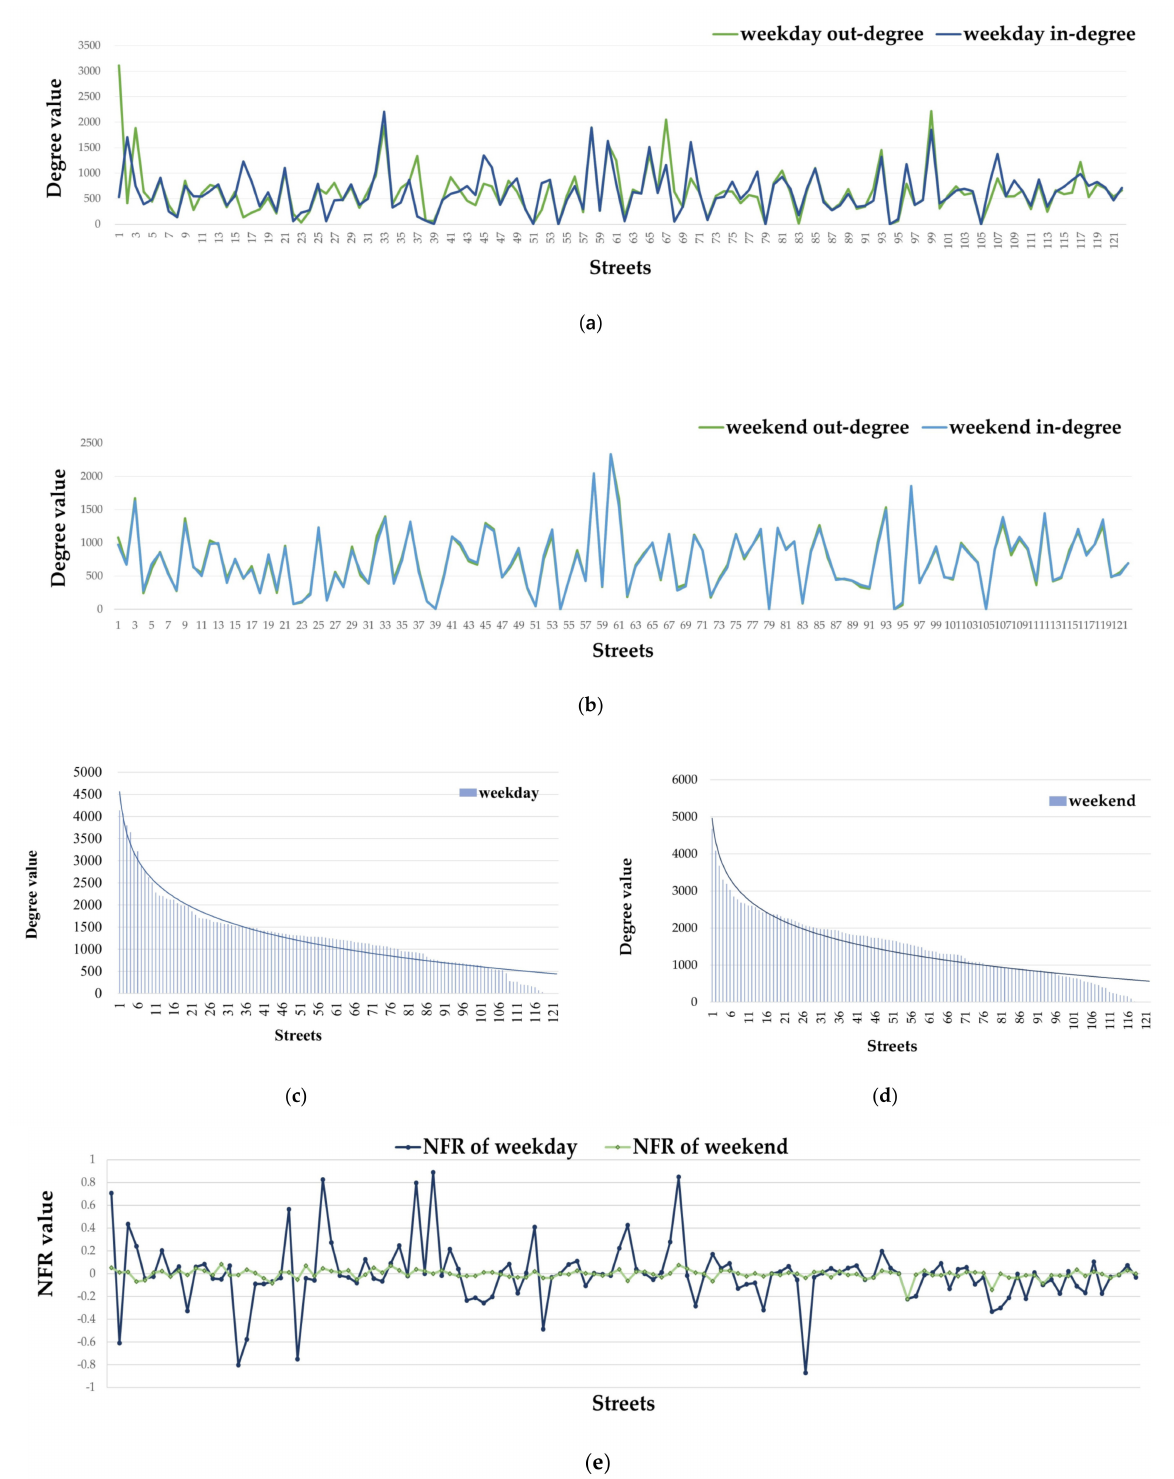
Figure 6. Analysis of travel network characteristics: ( a ) Analysis of in-degree and out-degree during weekday (19–21 May); ( b ) Analysis of in-degree and out-degree during weekend (22–23 May); ( c ) Analysis of node strength during weekday (19–21 May); ( d ) Analysis of node strength during weekend (22–23 May); ( e ) NFR (19–23